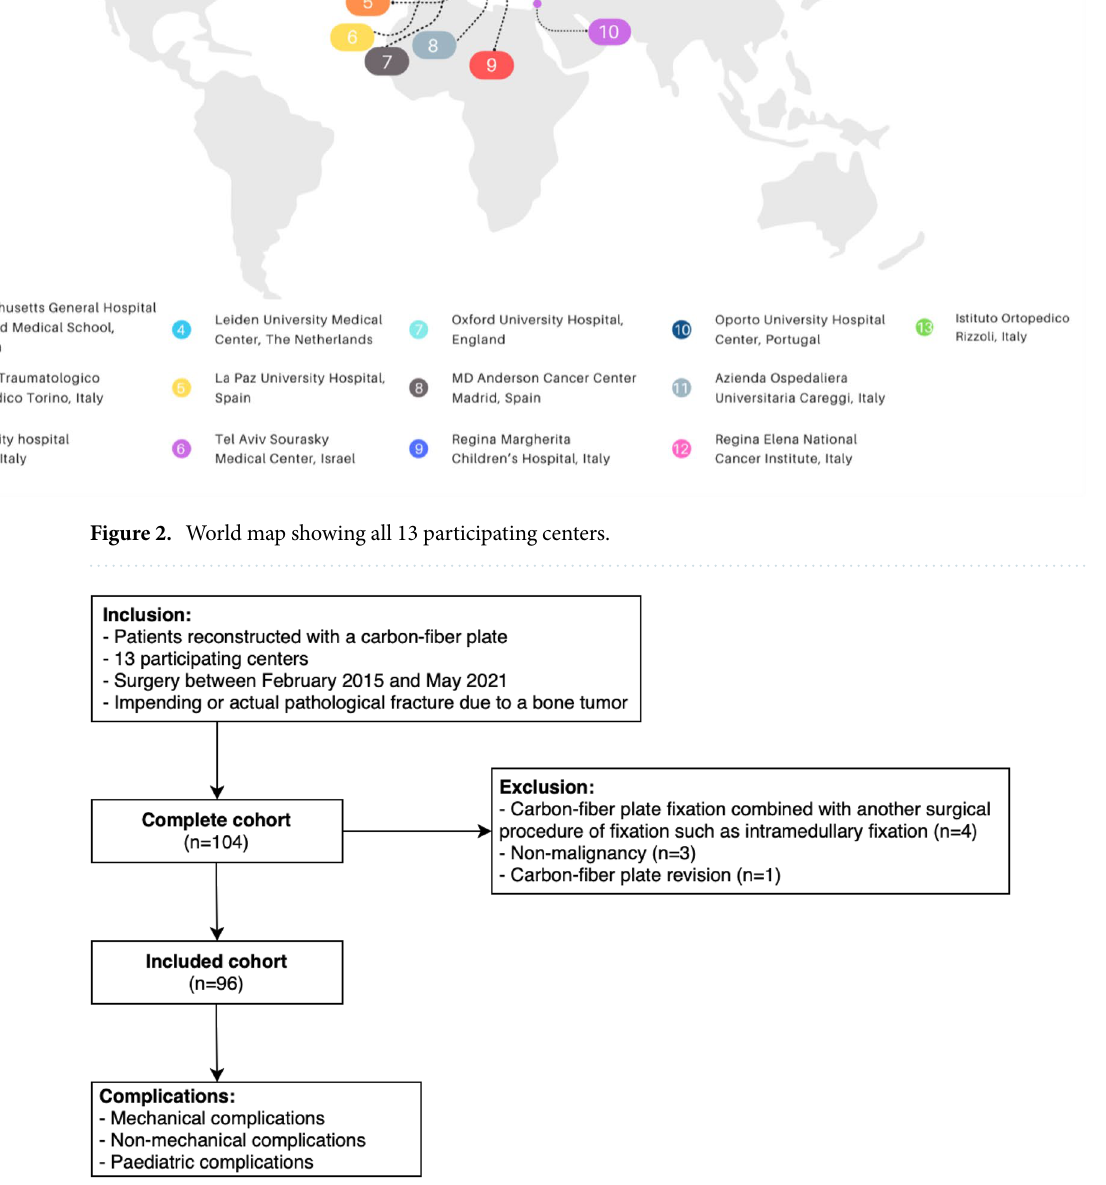
Figure 3. Flow diagram illustrating patient selection and